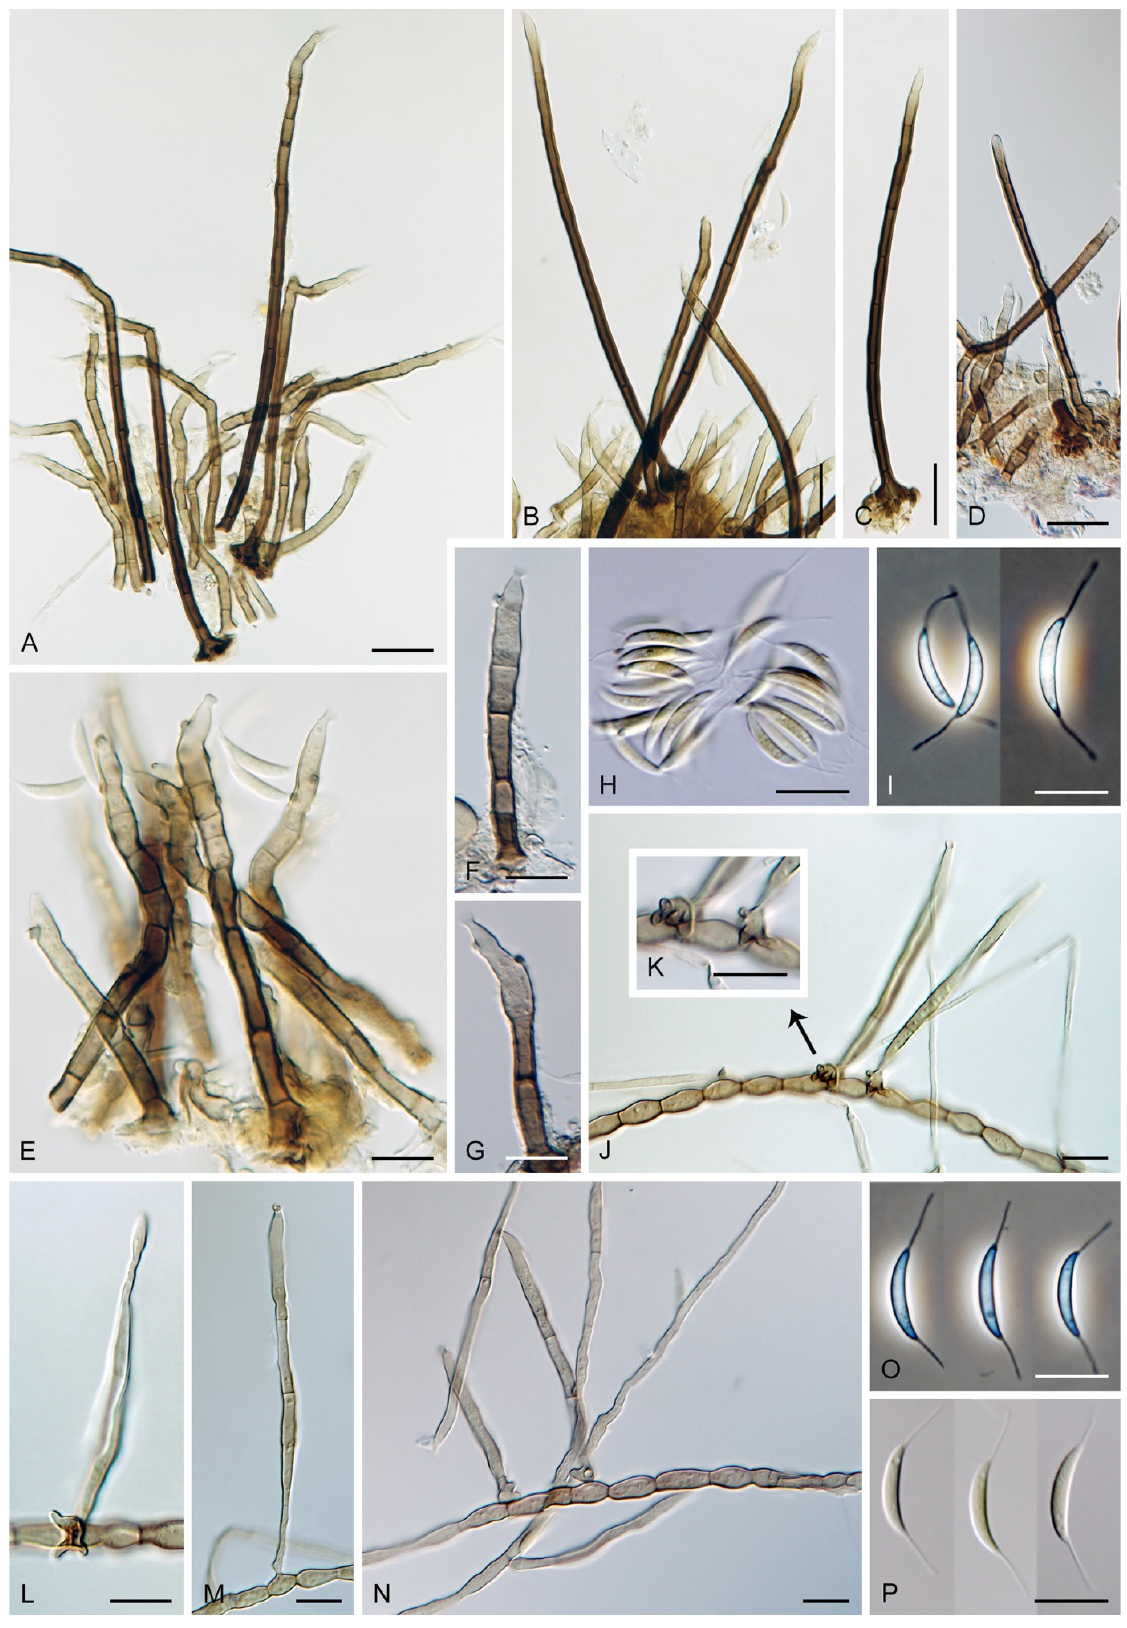
Figure 29. Codinaeella parvilobata (CBS 144536 ex-type). ( A – G ) Conidiophores ( H , I ) conidia ( J – N ) conidiophores ( O , P ) conidia. Images: ( A – I ) from natural substrate ( J – P ) on MLA after 4 weeks. Scale bars: ( A – D ) 20 μ m; ( E – P ) 10 μ m.